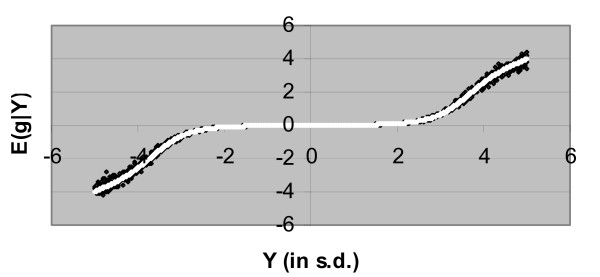
The expectation of the genetic value given the summary statistic of the data Y, E(g|Y), as a function of Y. The parameter of the exponential distribution is λ = 1, σ2 = 1, and the probability of a marker having a true effect is γ = 0.05; E(g|Y) calculated by numerical integration is represented by black dots and the analytical solution is shown as white dots.